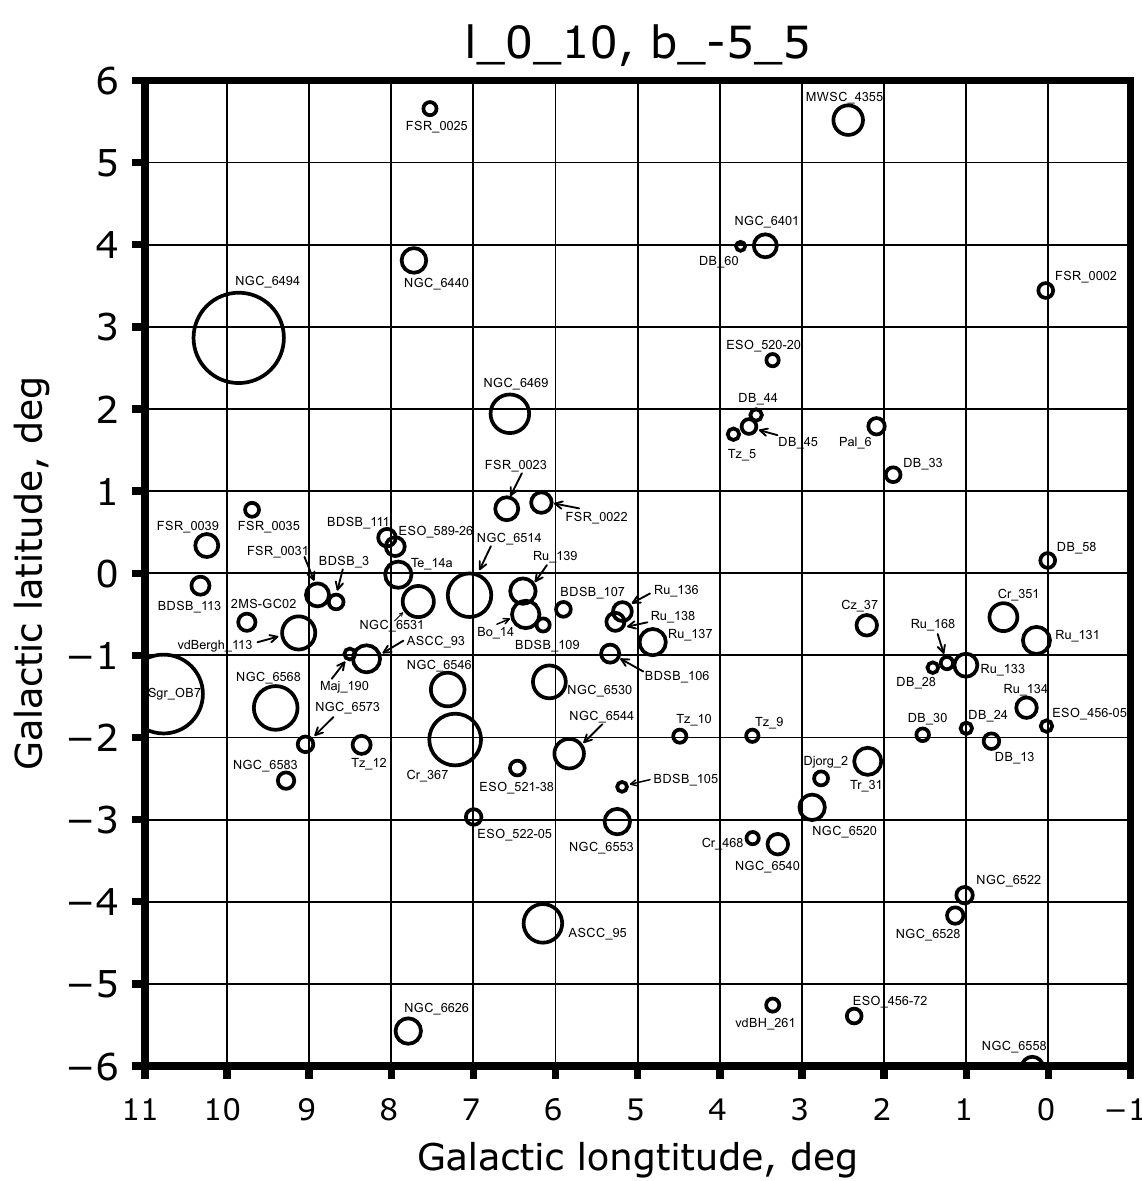
Figure 2. An example of the map for the galactic longitude of −1 < l < 11 degrees and the galactic latitude of −6 < b < 6 degrees (page 2 of the Atlas). The title in the upper part of the figure designates an interval in galactic longitude (l) and galactic latitude (b).